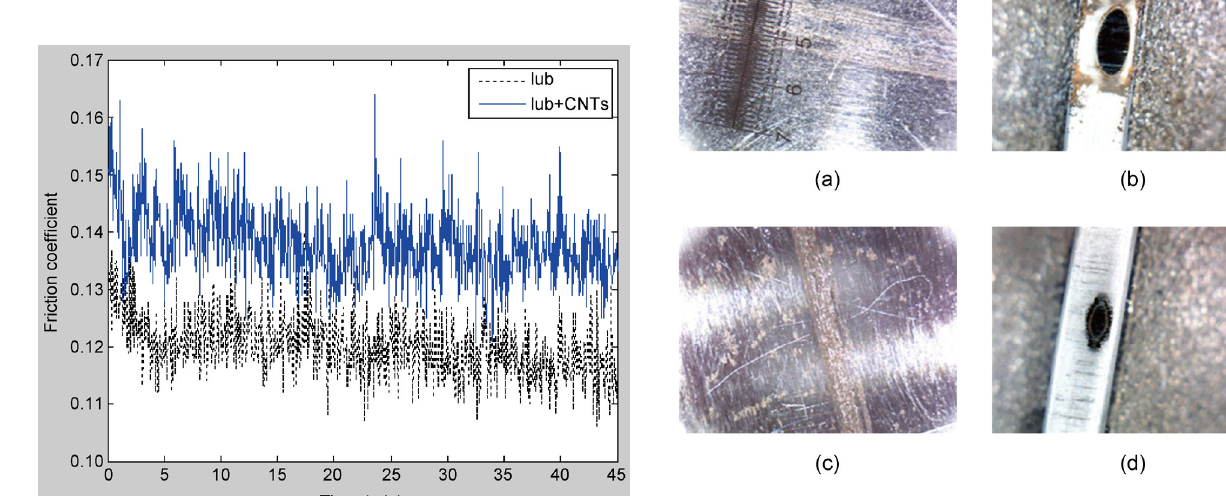
Fig. 6 Wear scar under dry sliding conditions. (a) Cylinder liner without CNTs; (b) piston ring without CNTs; (c) cylinder liner with CNTs; (d) piston ring with